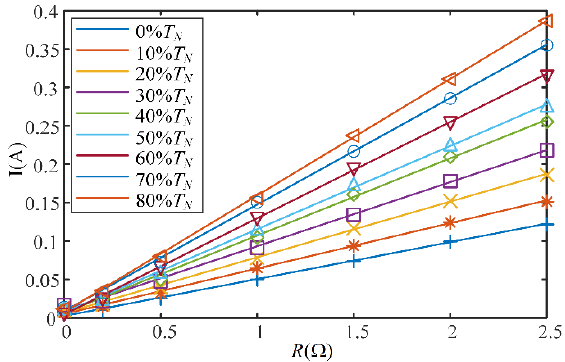
Figure 8. Motor negative sequence current and its fitting curve.